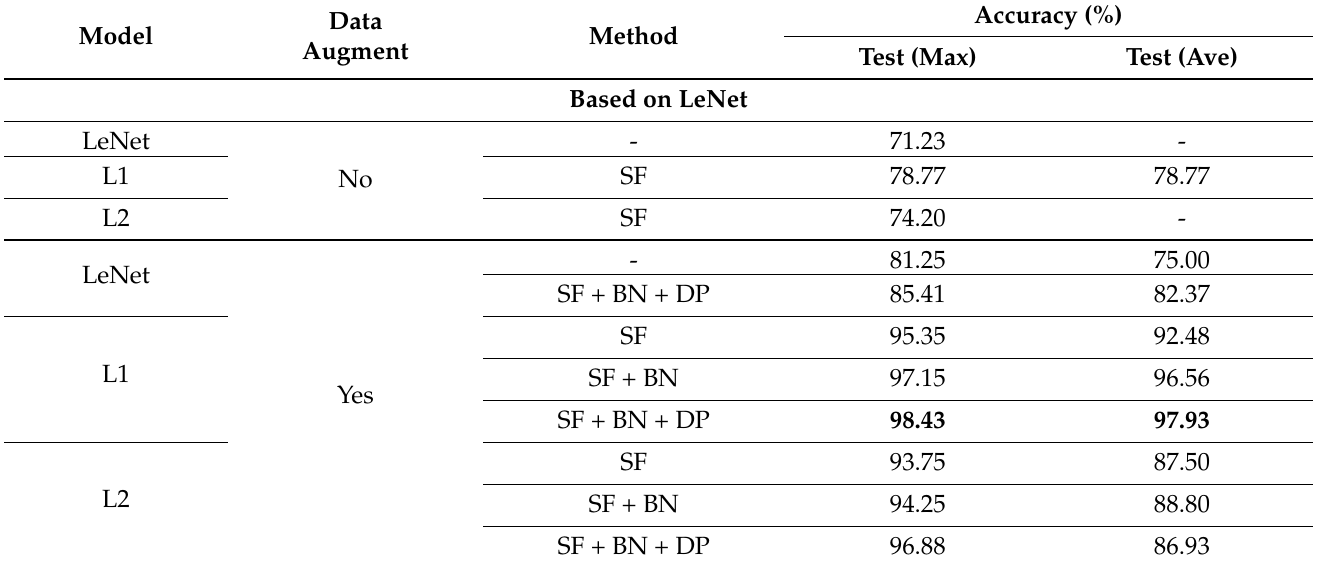
Table 2. Recognition accuracy of LeNet-based models on unaugmented (No) and augmented (Yes) OBI datasets. BN, DP, SF represent batch normalization, dropout, and shuffle methods,